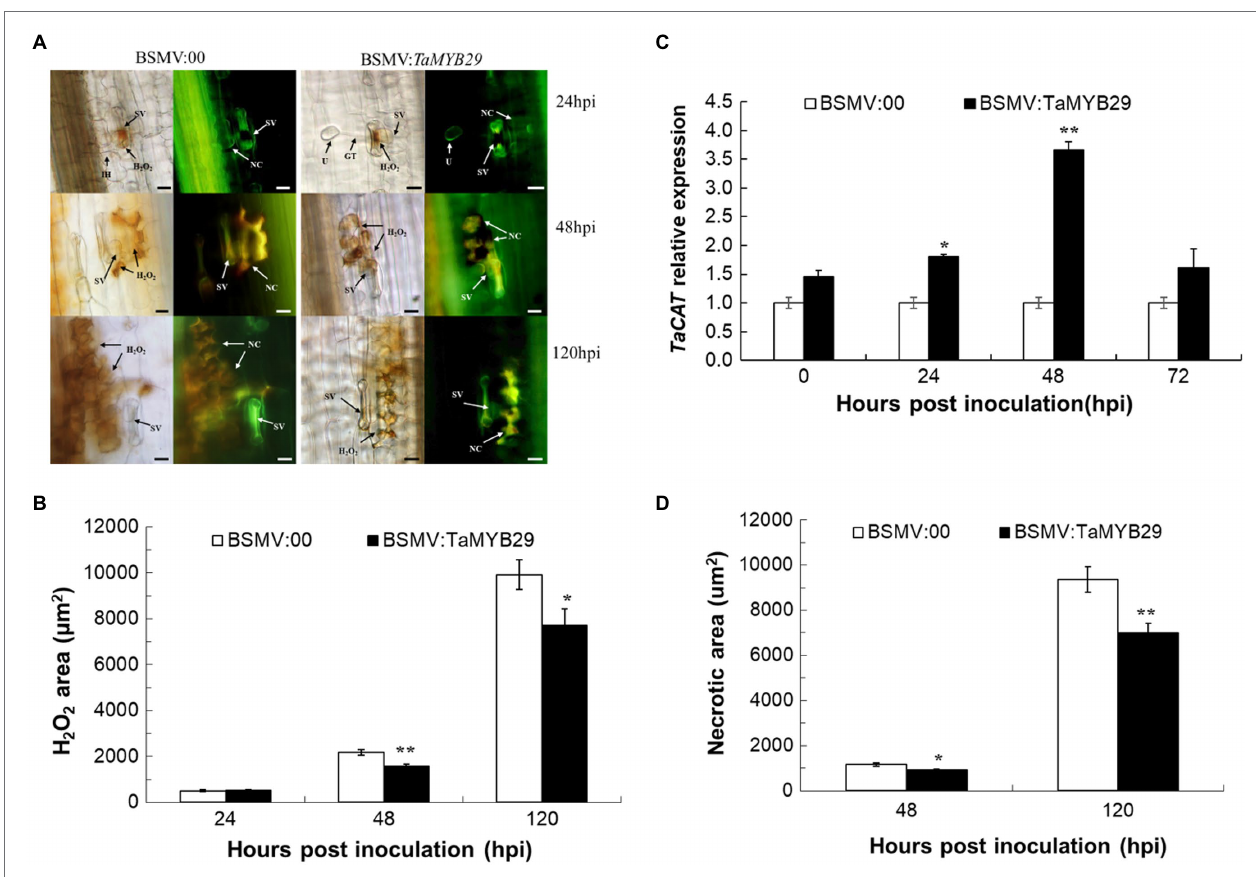
FIGURE 8 | Reactive oxygen accumulation and related gene expression and hypersensitive response in the TaMYB29 knockdown AvS+ Yr10 wheat leaves. (A) The reactive oxygen species and cell necrosis in wheat leaves in response to Pst observed under a fluorescence microscope. (B) The reactive oxygen species areas were stained with DAB and measured microscopically at 24, 48, and 120 hpi. H 2 O 2 accumulation was significantly reduced in TaMYB29 silenced leaves compared to the control. (C) Transcriptional level of ROS-related gene TaCAT in AvS+ Yr10 after TaMYB29 -scilencing at four time points relative to the expression in BSMV:00. (D) Cell death was measured microscopically because of the auto-fluorescence of necrotic cells at 48 and 120 hpi. The area of green auto-fluorescence reduced in TaMYB29 -silenced wheat plant. Pictures were taken under an epifluorescence or light microscopy at 24, 48, and 120 hpi, respectively. BSMV:00 is the control group and BSMV: TaMYB29 is the experimental group in which TaMYB29 gene was silenced. U, urediniospore; GT, germ tube; NC, necrotic cell; SV, substomatal vesicle; IH, initial hyphae; HMC, haustorial mother cell; and SH, secondary hyphae. Bars = 20 μ m. Error bars represent standard deviation among three biological replications. Student’s t -tests were used to for the statistical analyses and the asterisks ( ∗ ) and ( ∗∗ ) indicate a significant difference between particular hpi and controls with a value of p < 0.05 and 0.01,